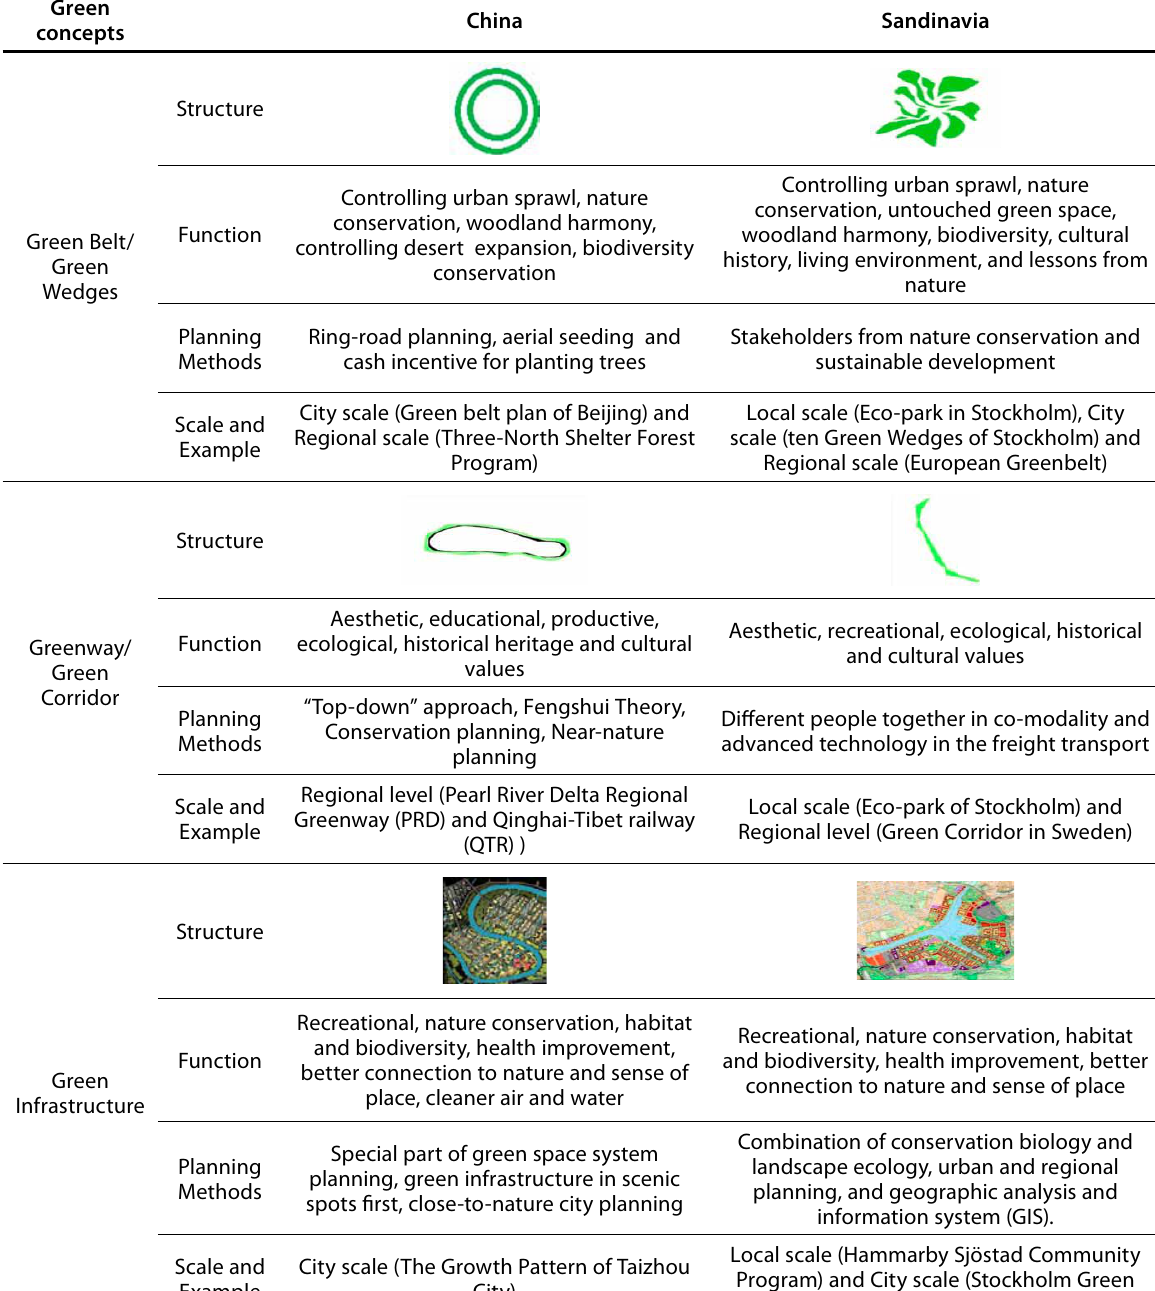
Table 1. Comparison of the application of green space planning and management concepts in China and Scandinavia Green China Sandinavia concepts